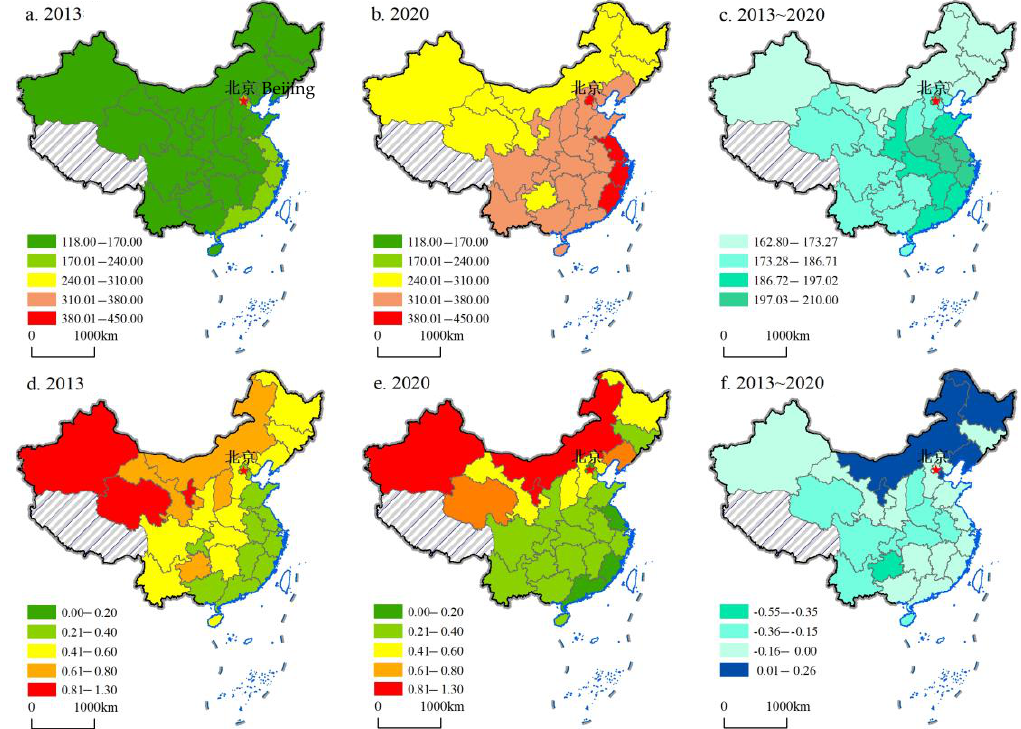
Figure 2. The spatiotemporal pattern characteristics of digital finance and green development. ( a – c ) represents digital finance, and ( d – f ) represents green development.